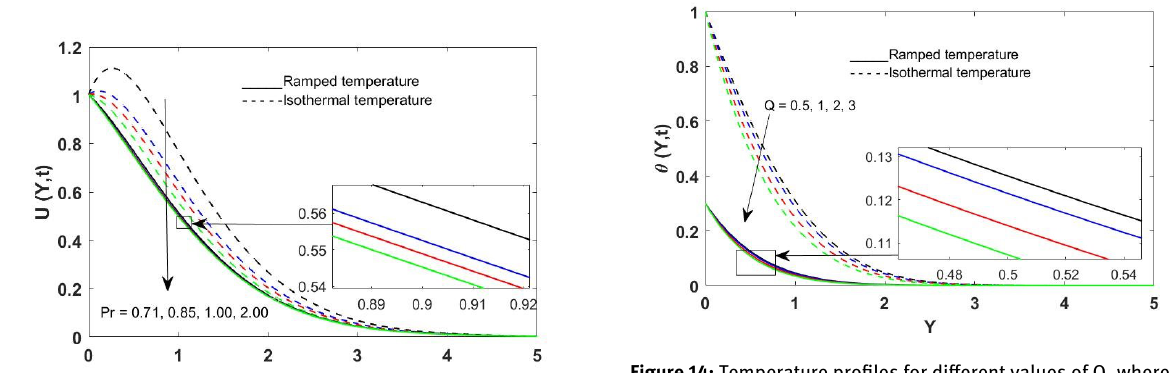
Figure 14: Temperature profiles for different values of Q, where Pr =0.71, t =0.3, R=0.2